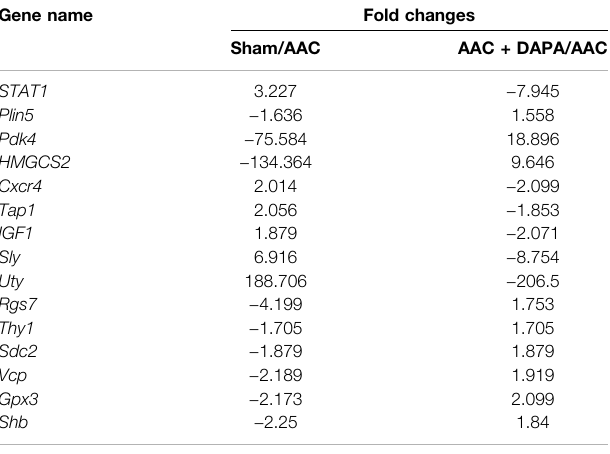
TABLE 1 | Fold changes of representative genes shown in the original article.